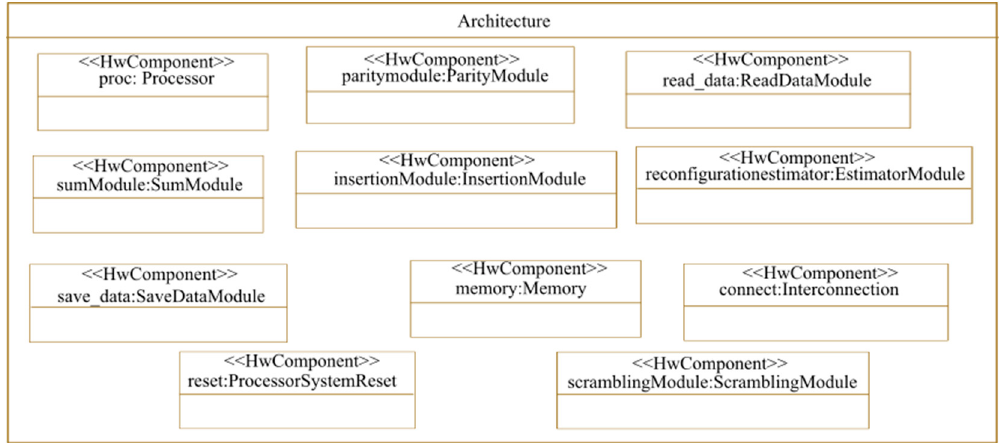
Figure 9. Architecture modeling.